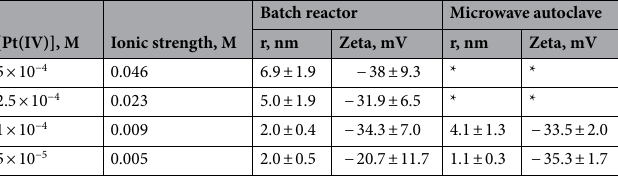
Table 1. Radius and Zeta potential of PtNP obtained at 20-fold excess of TCS. *The colloid was not obtained.